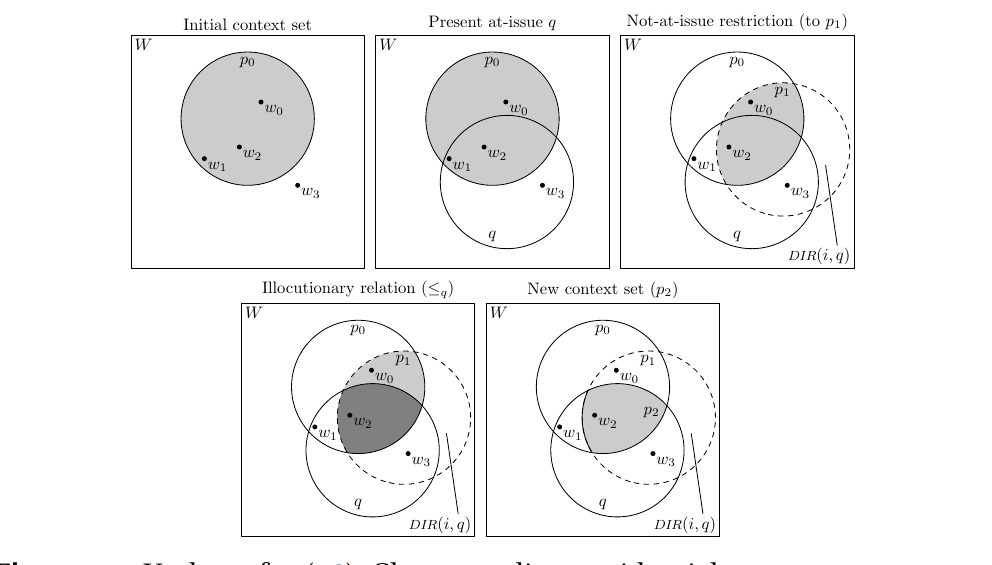
Figure 7 Updates for ( 26 ): Cheyenne direct evidential As discussed above, I use the UC distinction between the top and bottom ω sequence to distinguish at-issue and not-at-issue content. I use the bottom sequence to track the at-issue propositions, propositions we are discussing, but are not (yet) committed to, and the top sequence to track the context set. Not-at-issue information directly eliminates worlds in the top sequence. At-issue information does not. Instead, at-issue information is added to the bottom sequence and a proposal is made about what to do with it. There could be a proposal to add it to the common ground, to add its possibility to the common ground, or to leave the common ground as is. My translation of Cheyenne ( 26 ) into UC is ( 27 ). See Appendix A for ω complete definitions and abbreviations for UC ω